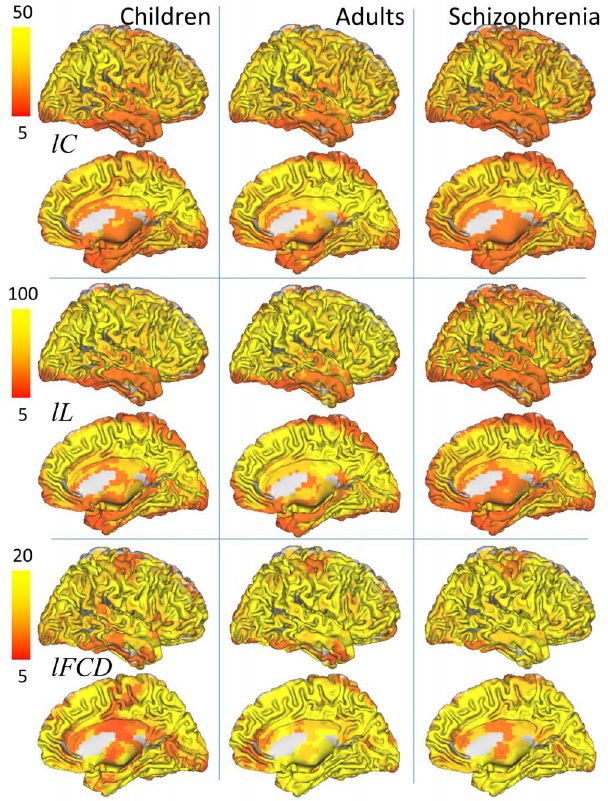
Figure 1. Statistical significance of graph theory metrics. T-score maps corresponding to local clustering, lC , characteristic path length, lL , and functional connectivity density (degree), l FCD, for 40 typically developing children, 74 healthy adults and 69 schizophrenia patients, superimposed on lateral and medial views of the human brain surface. Correlation thresholds: R T1 = 0. 50; R T2 = 0.65.